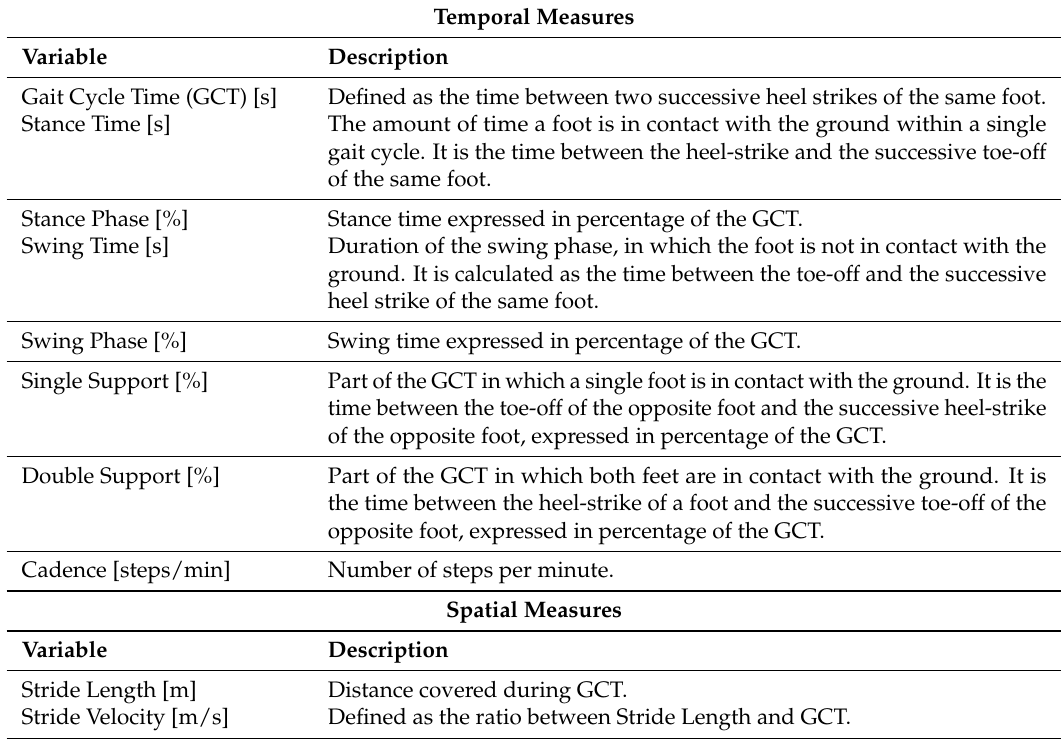
Table 1. Spatio-temporal gait